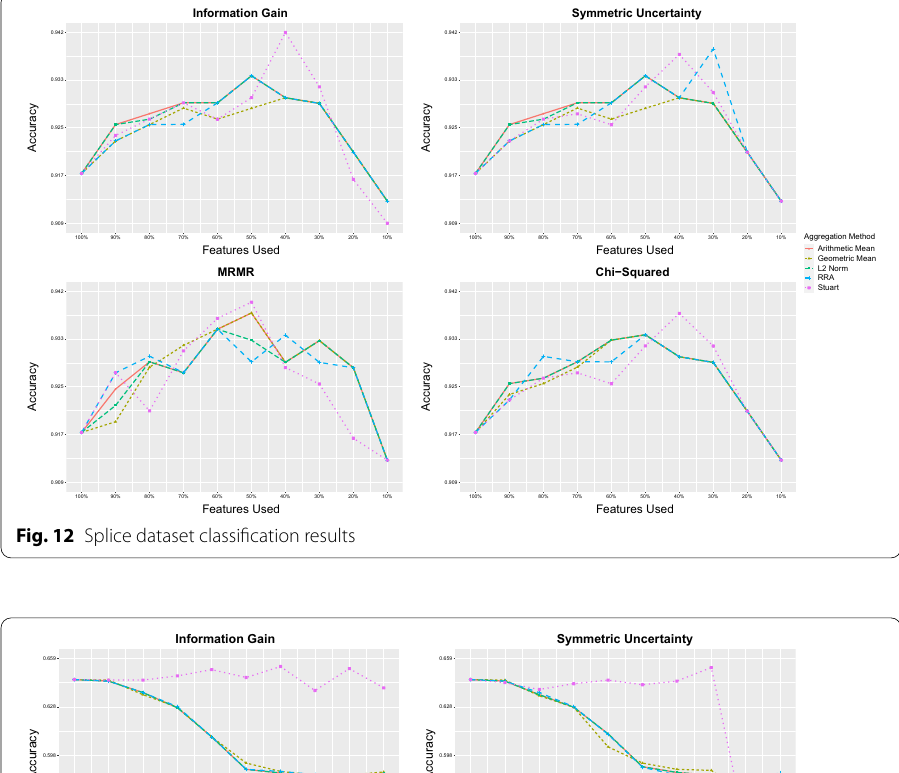
Fig. 12 Splice dataset classification results